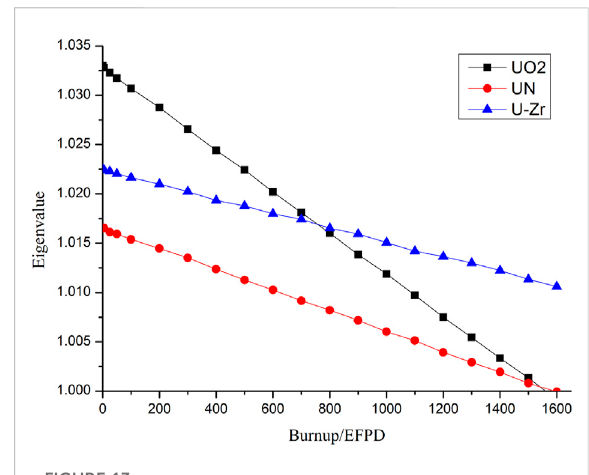
FIGURE 13 Eigenvalue results of the fuel material analysis in the burnup